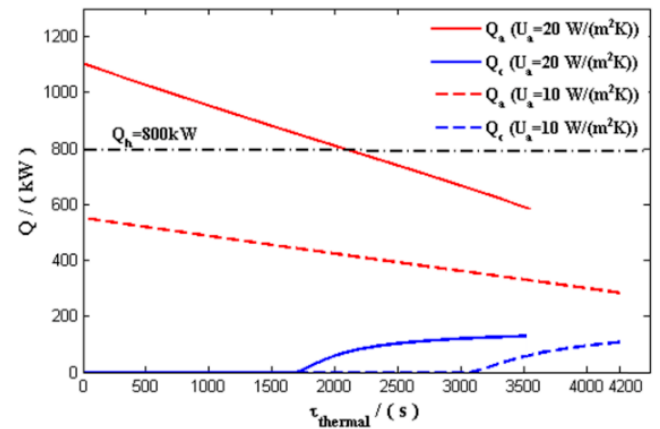
. . Q  Q  Q a and Q c and c . Figure 8. Change trend of